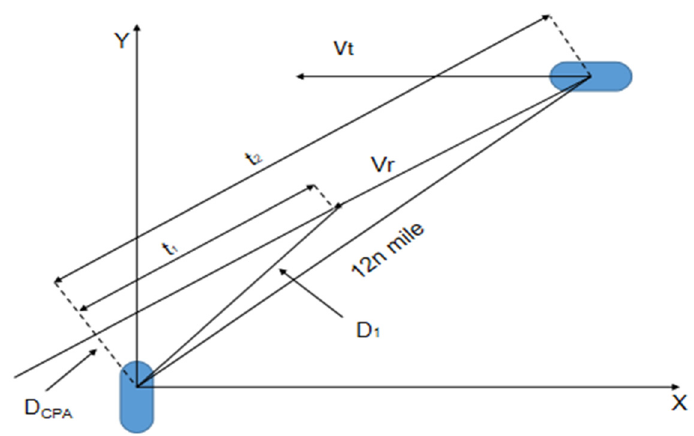
Figure 7. Geometric diagram of the latest avoidance distance.